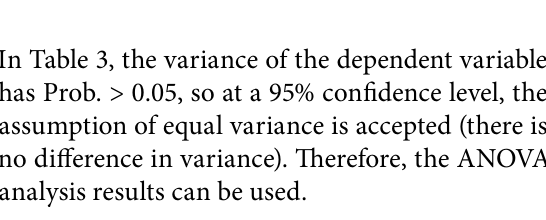
Table 3. Test of homogeneity of variances Levene statistic